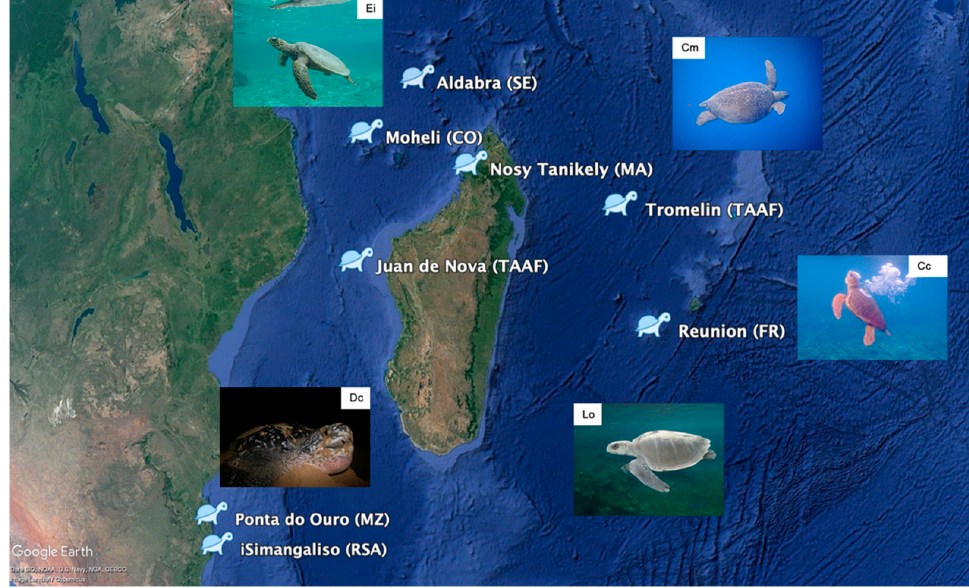
Figure 26. Release locations and sea turtle species to be equipped in the frame of the STORM-IO project: Ei: Eretmochelys imbricata (Hawksbill); Cm: Chelonia mydas (Green); Cc: Caretta caretta (Loggerhead); Lo: Lepidochelys olivacea (Olive Ridley); Dc: Dermochelys coriacea (Leatherback). Sources: background, Google Earth; Pictures, Kelonia